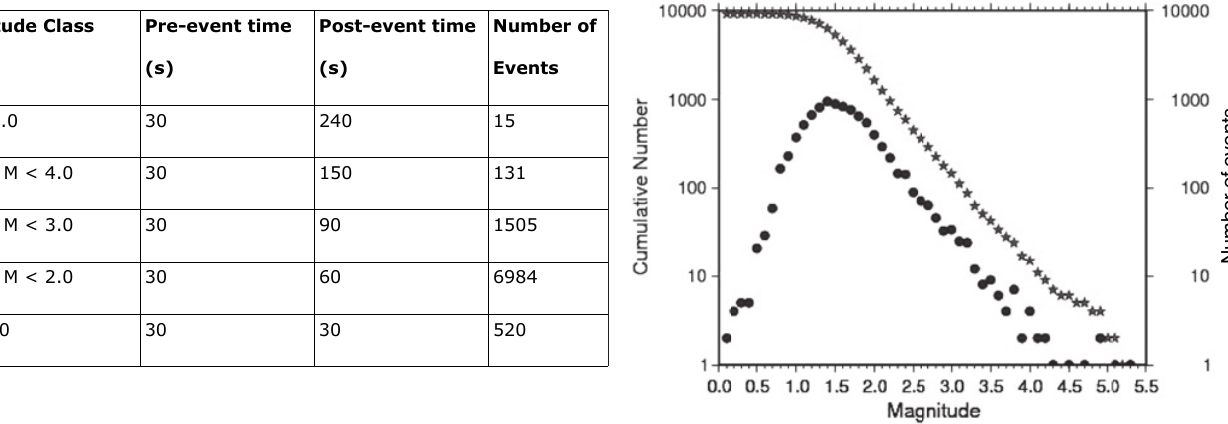
Table 4 (left). Selection criteria for waveform extraction. The increasing post-event times are related to the increasing ML. Figure 3 (right). All the selected earthquakes. The magnitude distribution (circles) and cumulative number of events according to magnitude (stars).